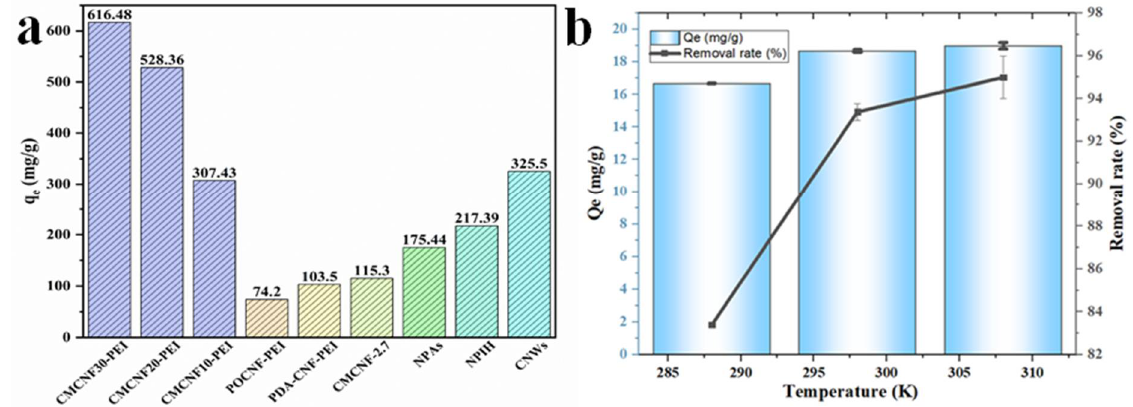
9 of 16 Figure 4. Effect of initial pH on Cu 2+ adsorption; ( a ) CMCNF10-PEI ( b ) CMCNF20-PEI ( c ) CMCNF30-PEI. ( d ) Contact time removal capacity for Cu 2+ adsorption (pH = 6, C 0 = 20 mg/L, T = 25 °C). ( e ) Plots of pseudo-first-order, and ( f ) pseudo-second-order of CMCNF10-PEI, CMCNF20-PEI, CMCNF30-PEI. ( g ) Effect of different initial concentration on Cu 2+ adsorption of three CMCNFs-PEI (pH = 6, t = 24 h, T = 25 °C). ( h ) CMCNF10, ( i ) CMCNF20-PEI, ( j ) CMCNF30-PEI isotherm model for Cu 2+ adsorption. 3.2.2. Adsorption Isotherms of CMCNFs-PEI Aerogel In order to confirm the interaction between CMCNFs-PEI and Cu 2+ , and that the max- imum adsorption capacity of CMCNFs-PEI is the key to evaluate its removal performance, we studied the relationship between the initial Cu 2+ concentration and equilibrium re- moval capacity of CMCNFs-PEI. The removal results of the CMCNFs-PEI with different initial concentrations of Cu 2+ are shown in Figure 4g–i. The adsorption isotherm parameters are displayed in Table 3. For CMCNF10-PEI, R 2 > 0.98; for other adsorbents (CMCNF20-PEI, CMCNF30-PEI), R 2 > 0.99. The results show that both Langmuir and Freundlich models can fit the adsorption isotherm well. The Langmuir model showed that the active adsorption sites were uni- formly distributed on the surface of the aerogel, and the adsorption of Cu 2+ ions occurred at the binding sites of functional groups and the surface, forming a monolayer [22]. How- ever, Freundlich isotherm is used in the low to intermediate adsorbate concentration range [23]. The maximum Langmuir adsorption capacity for Cu 2+ on CMCNF10-PEI aer- ogel was determined to be 307.43 mg/g. The adsorption capacity increased with the in- crease of carboxyl group content. The maximum adsorption capacity of CMCNF30-PEI was 616.48 mg/g, which was considered to be a super high capacity. This may be due to